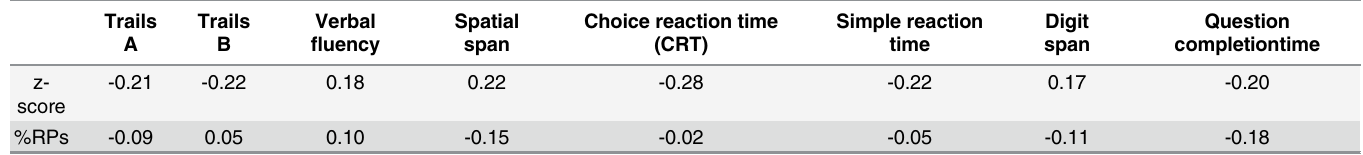
Table 5. Correlations with z-scores from other neuropsychological